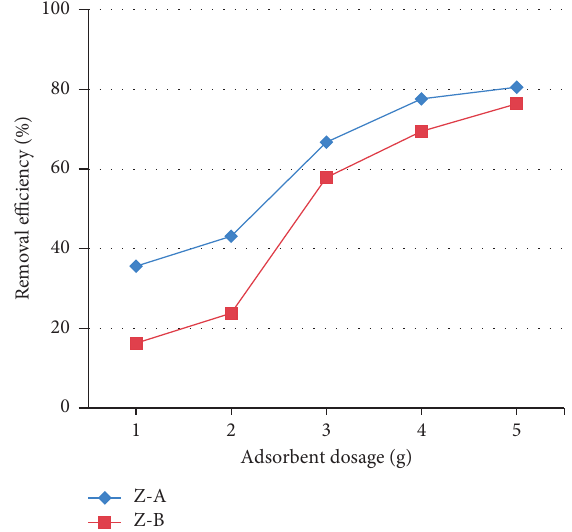
Figure 6: Effect of adsorbent dosage on removal efficiency of Z-A and